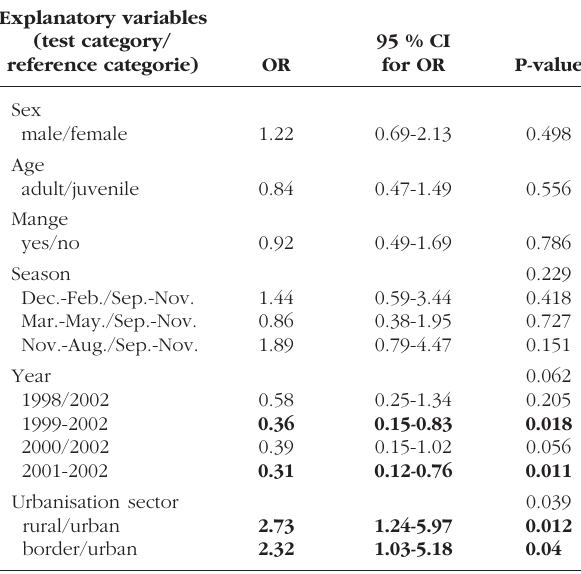
Table I. – Odds-Ratios, 95 % Confidence intervals and P-values of a full logistic regression model for the prevalence of E. multilocu- laris in foxes of Geneva (P ≤ 0.05 given in